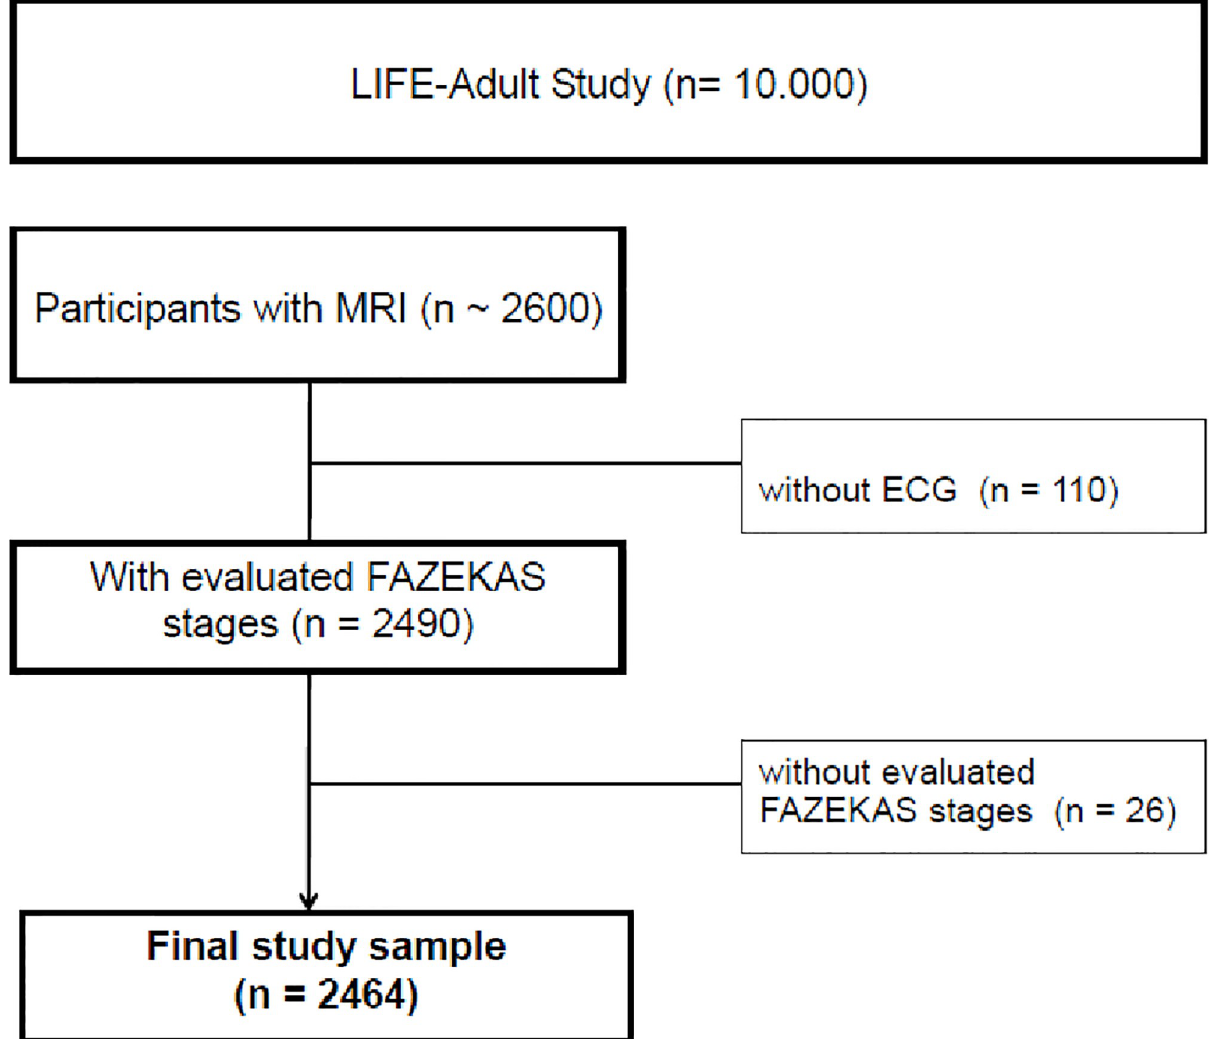
Fig 1. Flowchart of study population. 2636 participants underwent MRI imaging. 2464 participants had MRI imaging und ECG. The study sample of 2464 includes participants with evaluated FAZEKAS stages and ECG.